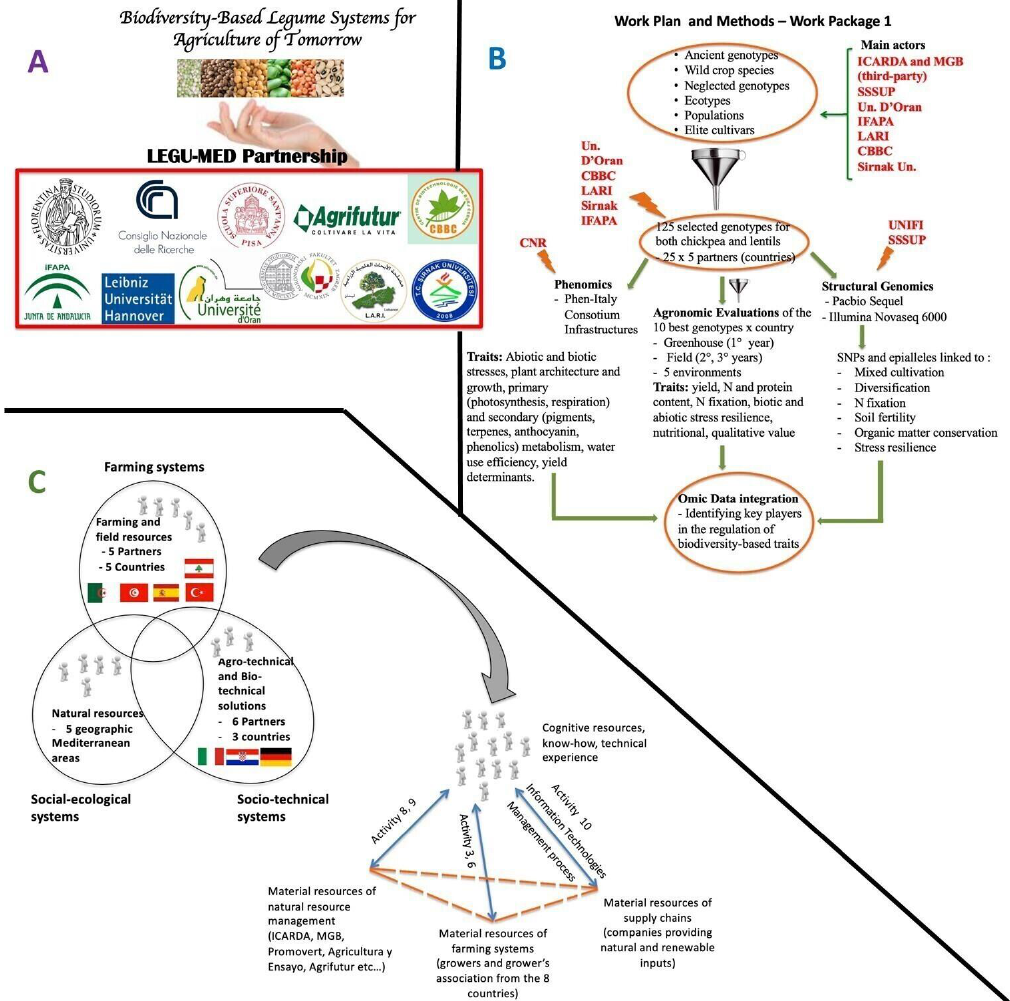
Figure 3. ( A ) International partnership of Legu-med proposal. ( B ) Structure of work package 1 com- posed of genomic, phenomic, and agronomic characterization of selected local and under-investi- gated autochthonous chickpea and lentil germplasm. ( C ) Integrated framework to design biodiver- sity-based farming systems at local level in Mediterranean basin.